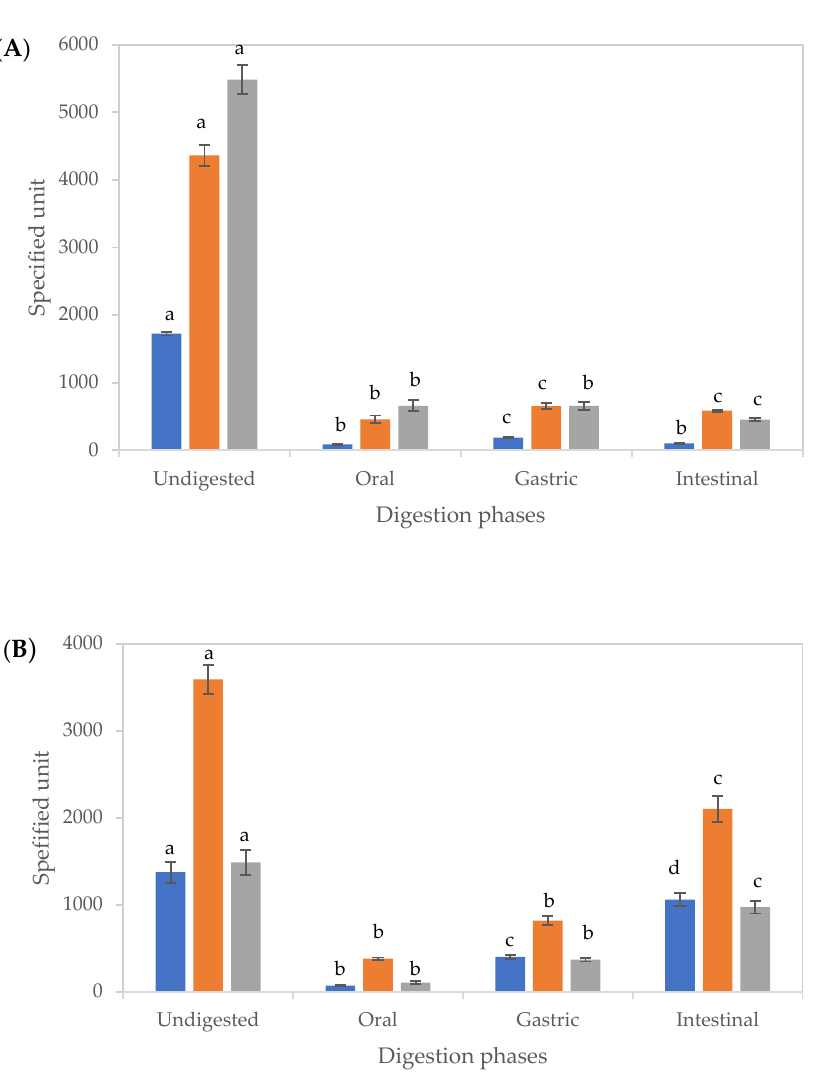
Figure 3. Changes in the total phenolic content and antioxidant activities of tamarillo extract ( A ) and tamarillo polyphenol loaded-cubosomes ( B ) before and after in vitro digestion. The units of TPC ( ◼ ), CUPRAC ( ◼ ) and FRAP ( ◼ ) were mg GAE/100 g tamarillo, μmol TEAC/100 g tamarillo and μmol TEAC/100 g tamarillo, respectively. Data are presented as mean and error bar (standard deviation) ( n = 3). Different alphabets indicate statistical difference ( p < 0.05) for each assay.